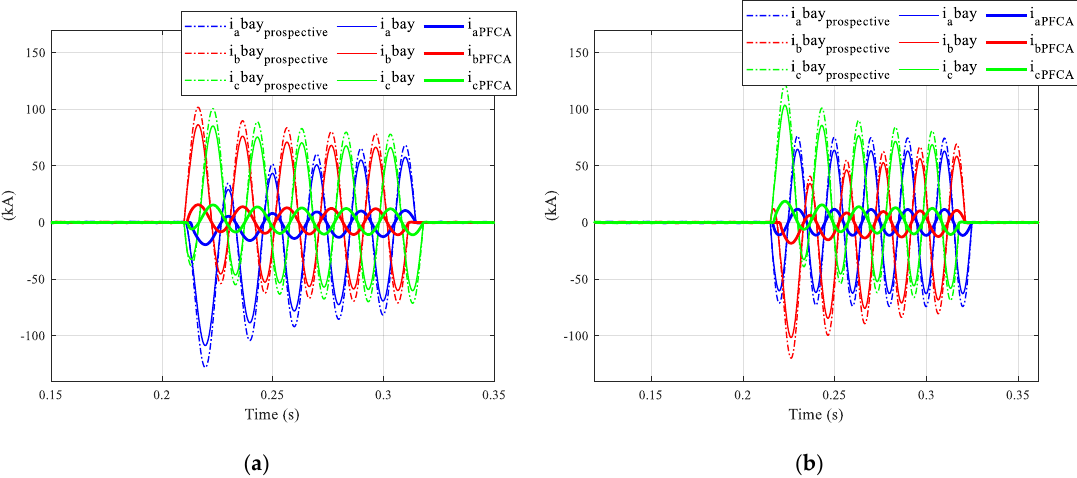
Figure 16. PFCA performance at different fault times. ( a ) Three-phase fault (0.21 s); prospective and